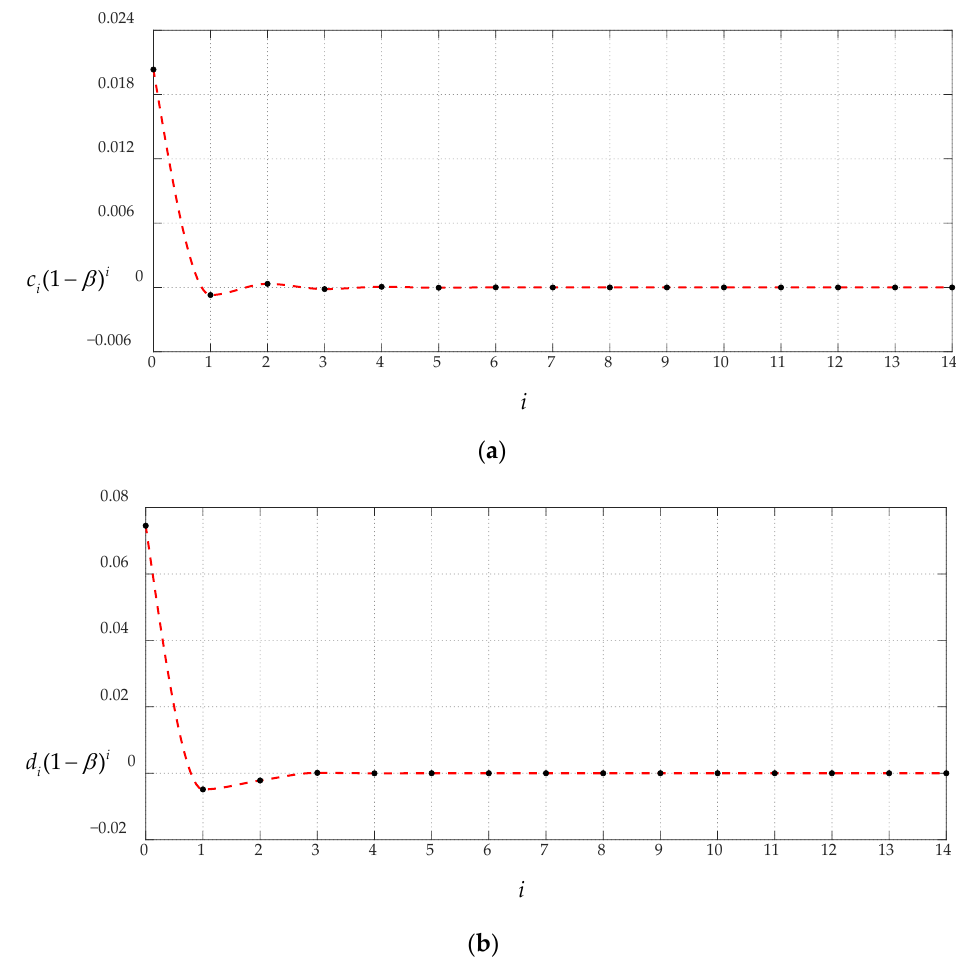
Figure 5. The variations of c i (1 − β ) i and d i (1 − β ) i with terms i , where q = 1.8 × 10 −3 MPa: ( a ) the variation of c i (1 − β ) i with i , and ( b ) the variation of d i (1 − β ) i with i .